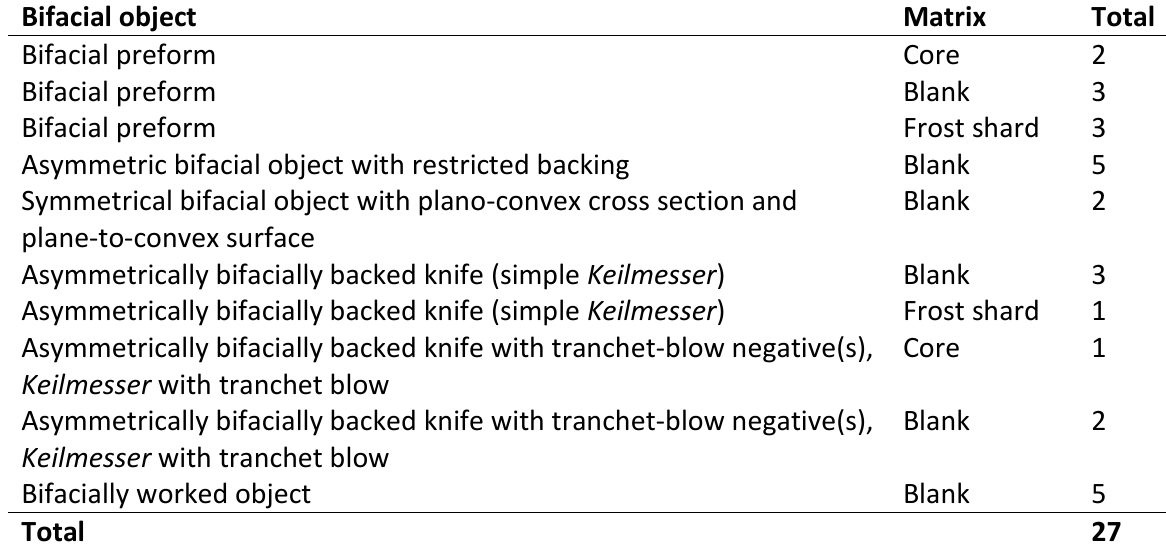
Figure 14. Examples of bifacial objects from GH 3. a) Bifacially worked object with two independent active edges (GER10.226-059.196), b) Keilmesser with tranchet-blow negative (GER12.229-059.428), c) Small symmetrical biface with two plane-to-convex surfaces (GER12.227-057.420) and d) Symmetrical bifacial object with plano-convex cross section and plane-to-convex surfaces (GER13.227-057.1790). For grey shades see explanation for Figure 10. Table 12. Bifacial objects of GH